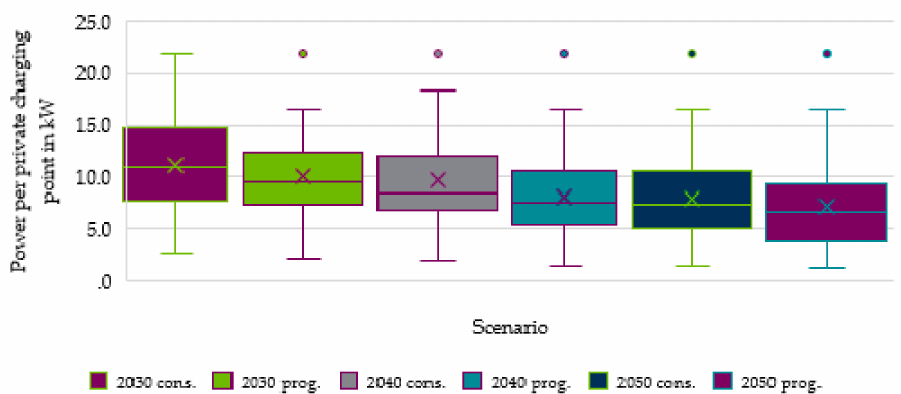
Figure 25. Average effective charging capacity per private charging point from the perspective of feeders (not including feeders without private charging infrastructure) for 20 low-voltage grids based on [41].